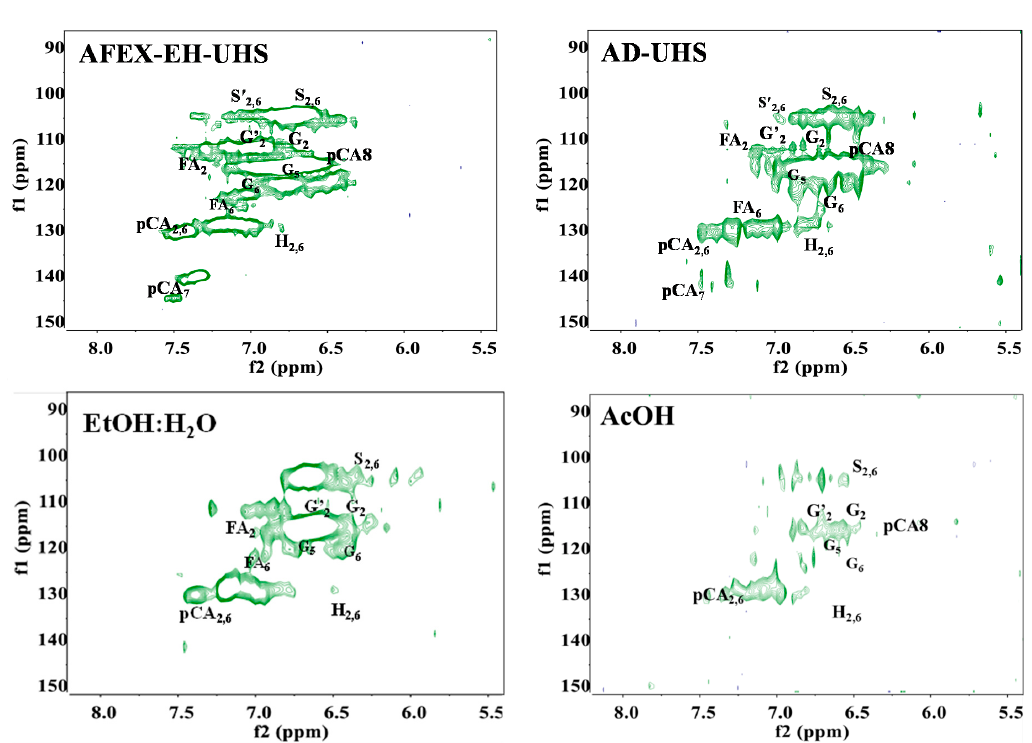
Figure 4. Aliphatic region of the 2D-HSQC NMR spectra of material extracted from AD-UHS with different solvents, and standard lignin of AFEX-EH-UHS and AD-UHS. Table 6. The assignments of major components in the HSQC NMR spectra. Name